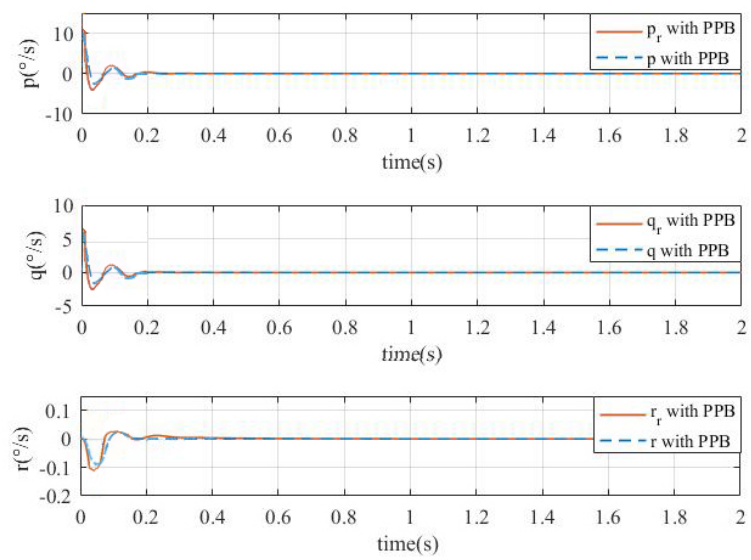
Figure 17. Tracking response of µ , α and β with PPB.